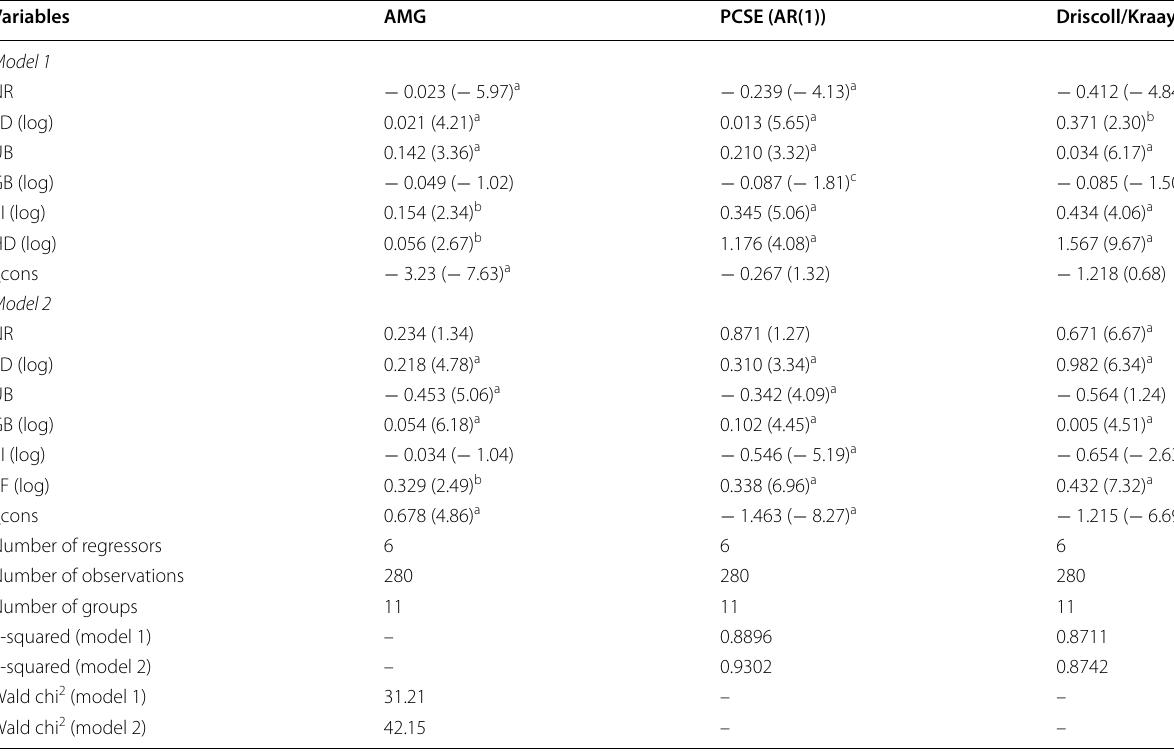
a,b,c Significance at 1%, 5%, and 10% levels, respectively. () are the t -stat